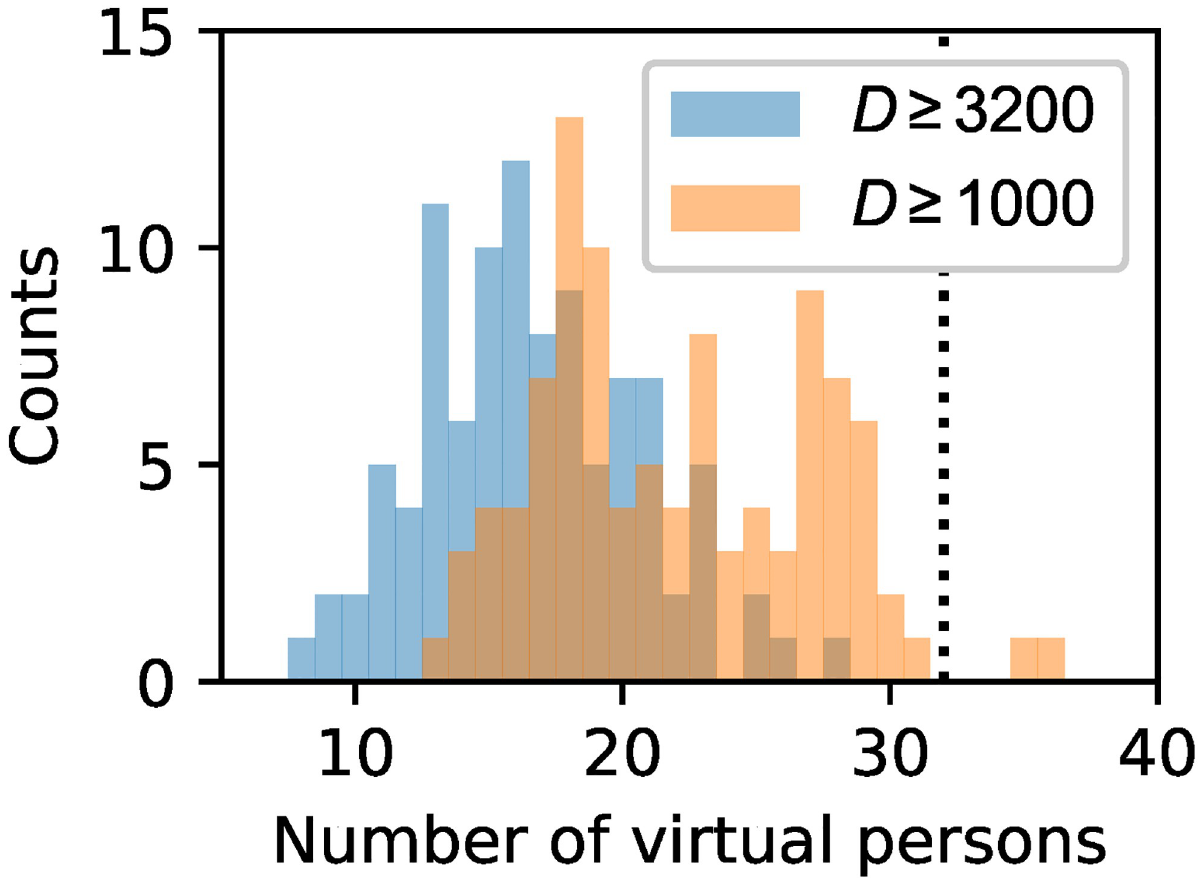
Fig 8. Virtual persons with degree of exposure D in the choir practice scenario. Number of persons for M = 100 simulations reaching a degree of exposure of D � 3.2 � 10 3 (close contact) and D � 10 3 virions. The dotted line indicates the 32 confirmed secondary cases of the true spreading event.